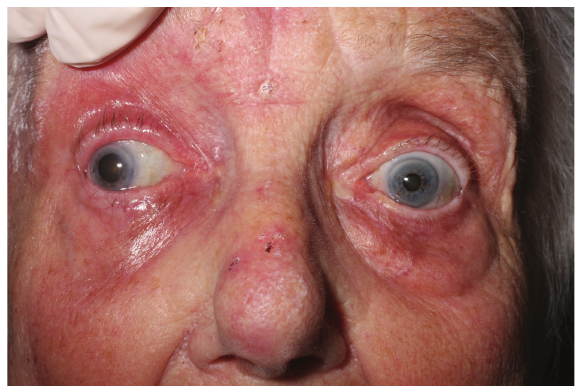
Figure 1: Oculomotor nerve palsy-pupil fixed and dilated in a position of lateral and downward gaze.